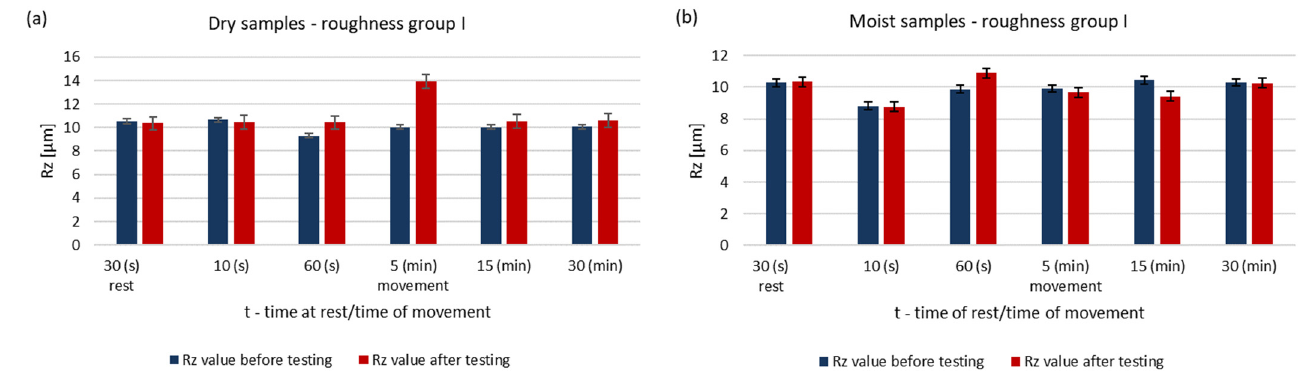
Figure 3. Changes in the value of the parameter Rz of steel pins for the roughness group I (Rz = 9.32–10.89 μ m): ( a ) tests performed in dry conditions, ( b ) tests performed with moist graphite rings.